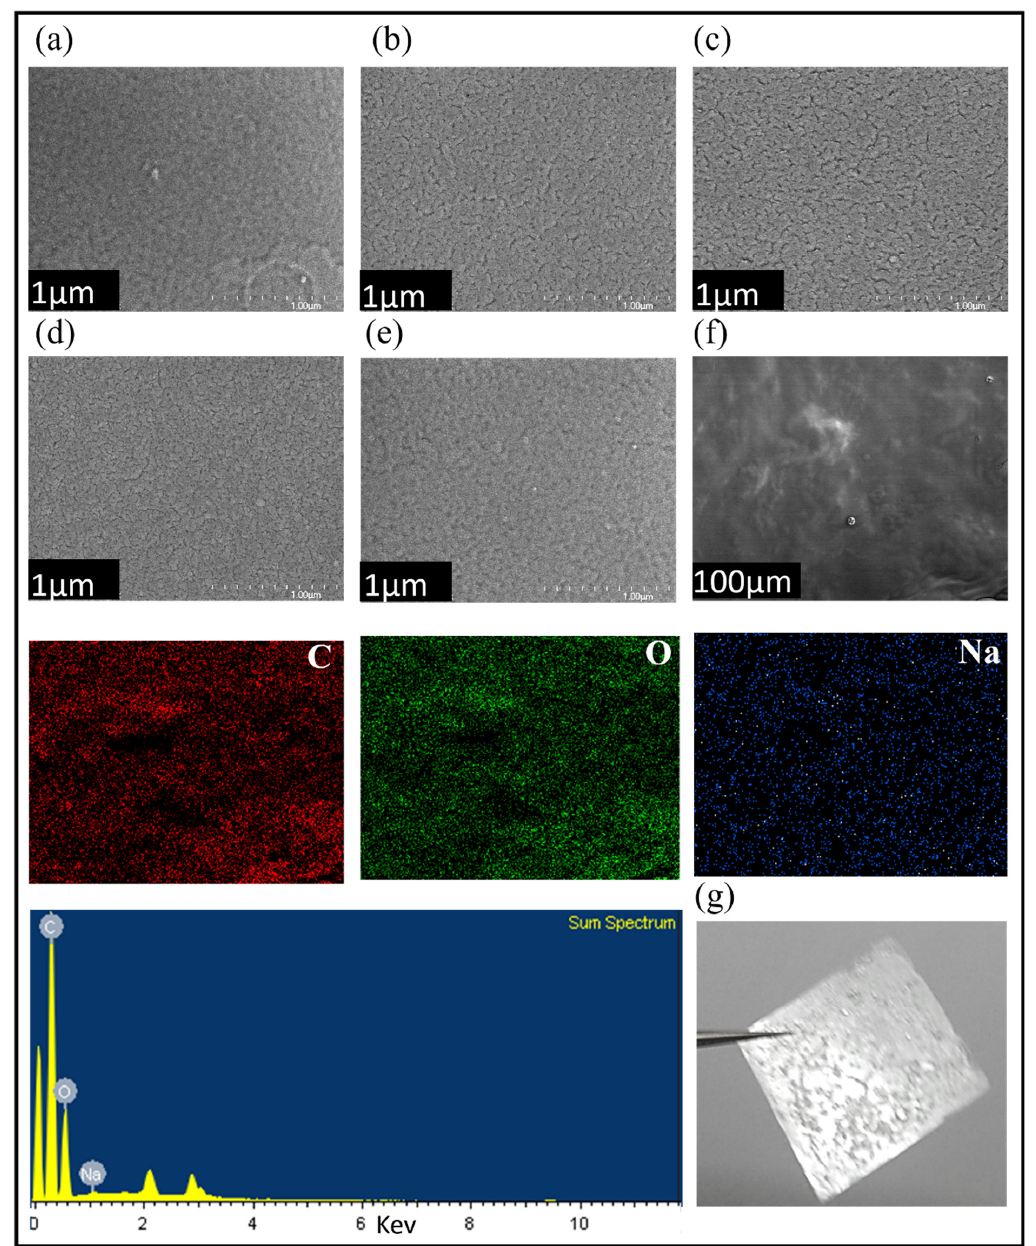
Figure 3. SEM images, digital photographs, and EDS mapping of PVA and composite CS ‐ PVA blends with different volume ratios: ( a ) PVA, ( b ) 90/10 CS ‐ PVA, ( c ) 70/30 CS ‐ PVA, ( d ) 50/50 CS ‐ PVA, ( e ) 40/60 CS ‐ PVA, ( f ) EDS mapping for C, O and Na in 70/30 CS ‐ PVA polymeric blend, ( g ) humidity ‐ sensing film with 70/30 CS ‐ PVA volume ratio.